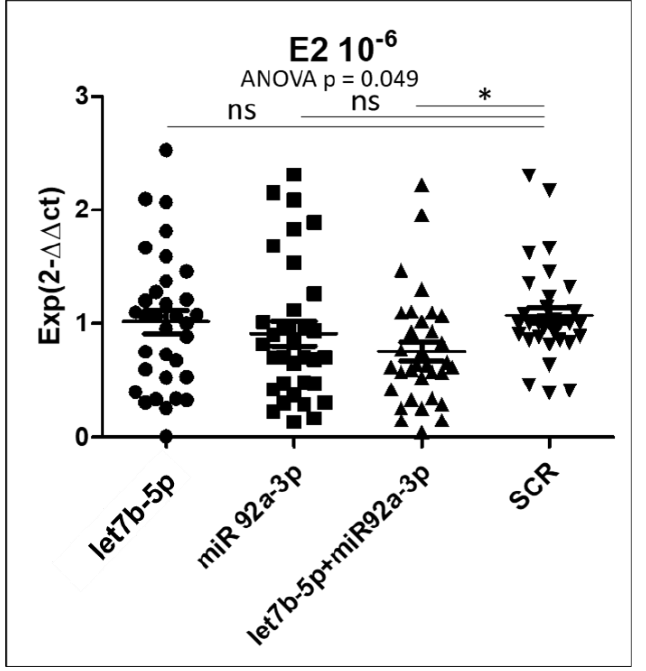
Figure 6. Effects of let-7b-5p , miR-92a-3p and both of them on KIAA1324 expression in human endometrial cells transfected with miRNAs mimics and treated with 17 β -estradiol. The KIAA1324 level of expression was measured by qPCR. E 2 = estradiol. The values of the transcript molecules were normalized to the values of scrambled (SCR) miRNA ( n = 10 patients). For the post-hoc t -test, following ANOVA: *, p<0.05.